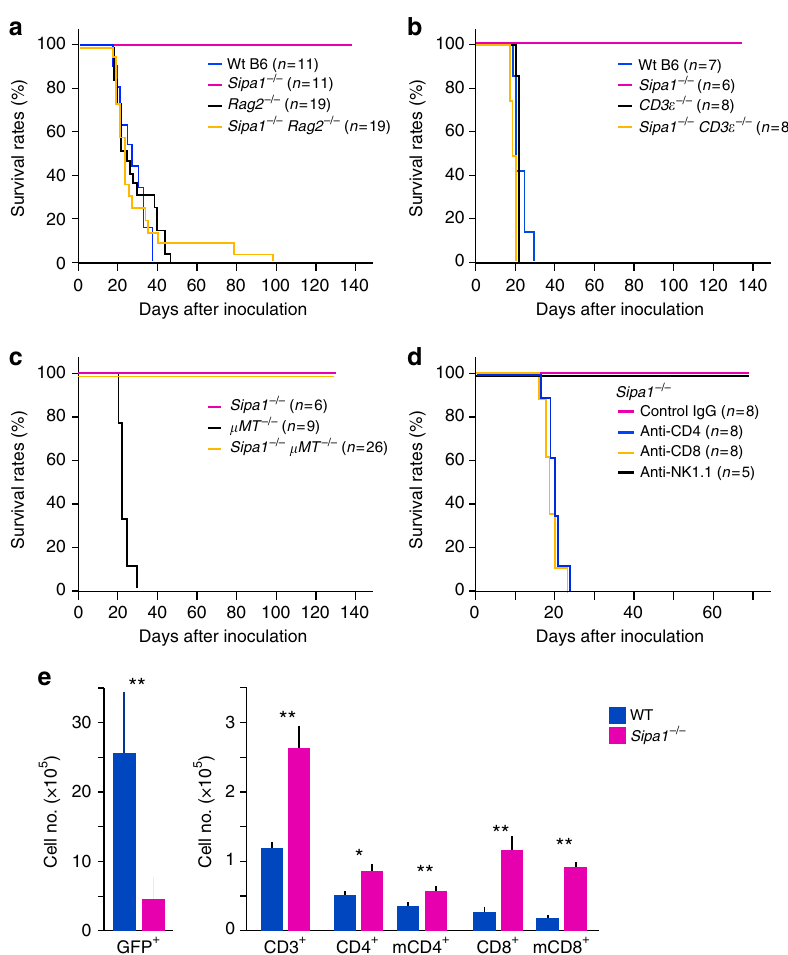
Fig. 4 T cells of both CD4 + and CD8 + cell types are essential for CML resistance of Sipa1 − / − mice. a – c Sipa1 − / − mice were crossed with Rag2 − / − , CD3 ε − / − , or μ MT − / − mice to generate double KO mice, and Bcr-Abl + HPCs of Wt B6 mice were intravenously injected in the unirradiated mice. Survival curves of the indicated numbers of mice per group are shown. d Sipa1 − / − mice were injected with anti-CD4, anti-CD8, anti-NK1.1 antibody, or control IgG twice per week beginning from the day before the injection of Bcr-Abl + HPCs. The antibody treatment was con fi rmed to eliminate more than 95% of the corresponding cell types in the spleen. Survival curves of the indicated numbers of mice per group are shown. e Wt and Sipa1 − / − B6 mice were intravenously injected with Bcr-Abl + HPCs at 1.5 × 10 4 cells per mouse, and 12 days later the BM cells were harvested and multi-color analyzed with indicated markers using FACS Canto. The means and SEs of cell numbers of indicated cell populations of fi ve mice per group are shown. * p < 0.05; ** p < 0.01 (two-tailed unpaired Student ’ s t -test); m memory phenotype. The similar experiments were repeated two times with similar